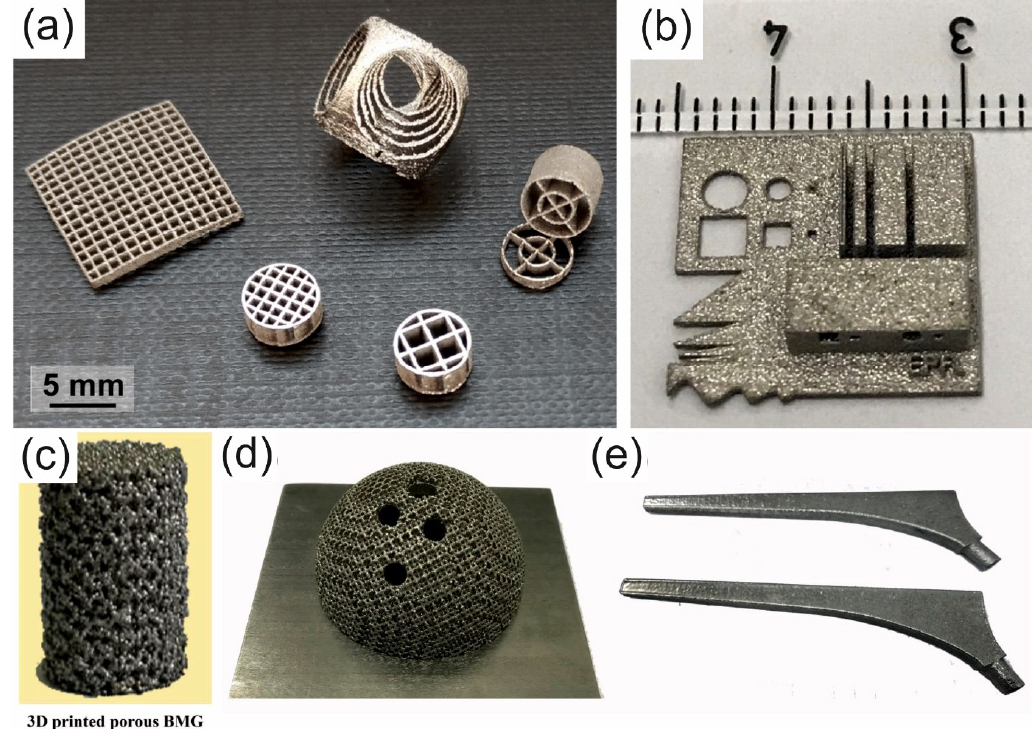
Figure 14. Samples with complex geometries in ( a ) Reproduced from [33], with permission from Elsevier, 2021. ( b ) Repro- duced from [32], with permission from Elsevier, 2021. ( c ) porous BMG part, and ( d , e ) LPBF parts used for biomaterials applications. Reproduced from [50], with permission from Elsevier, 2021.